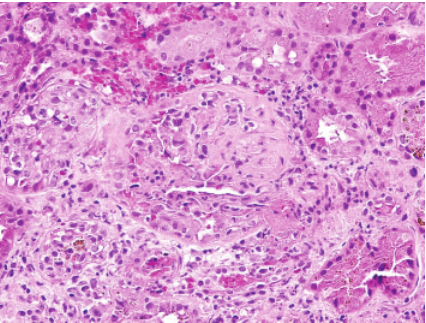
Figure 1: Case 1. Glomeruli with fibrocellular crescent and segmen- tal necrosis. Hematoxylin & Eosin, 200x magnification.